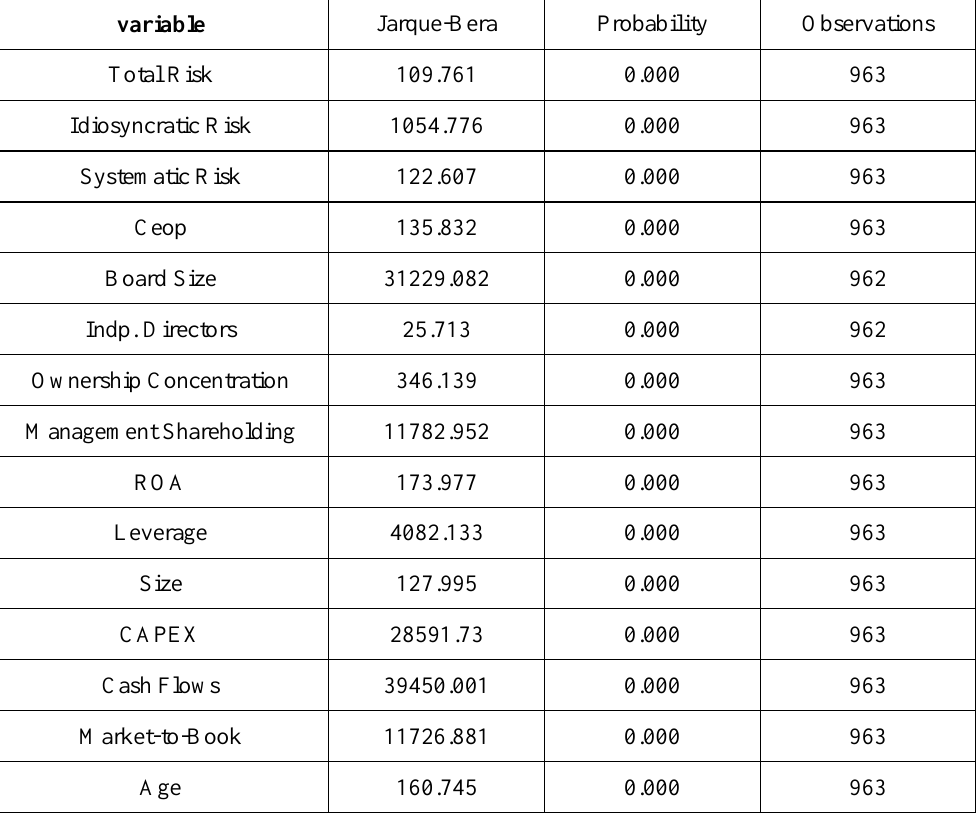
Table 4. normality test of the